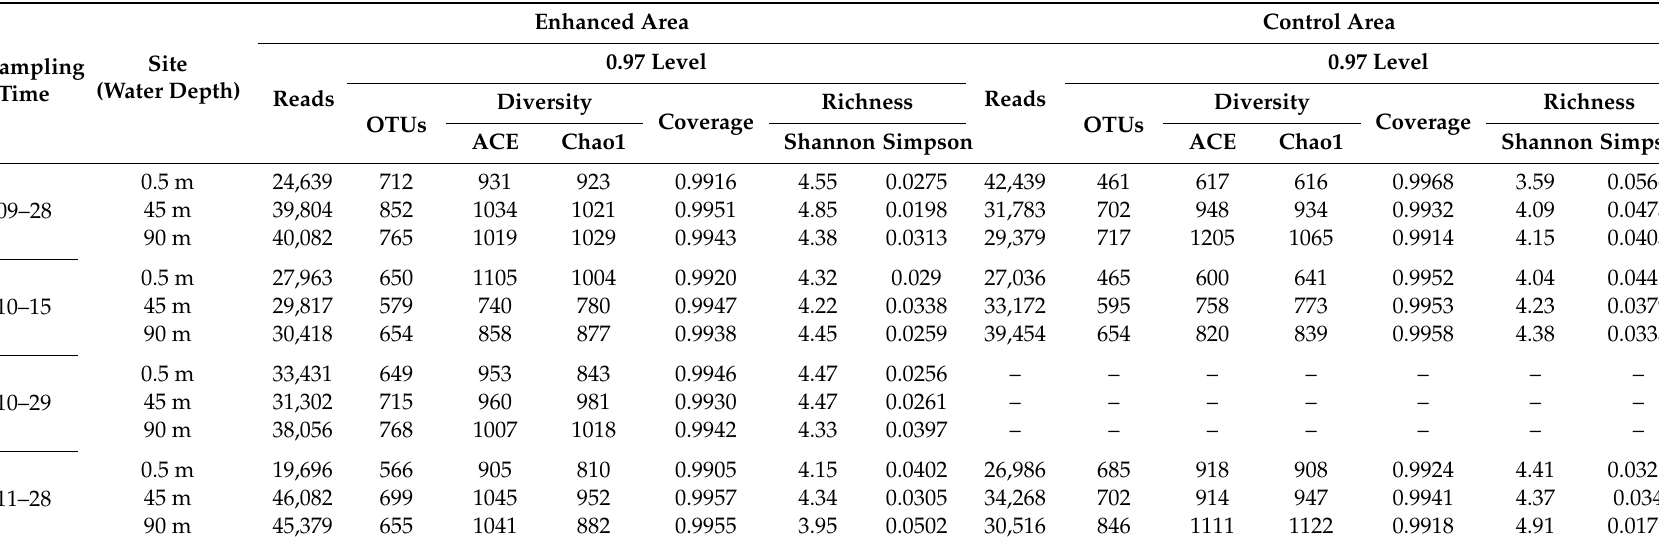
Table 1. Spatial and temporal distribution of the microbial community diversity and richness estimators in the enhanced and control areas.